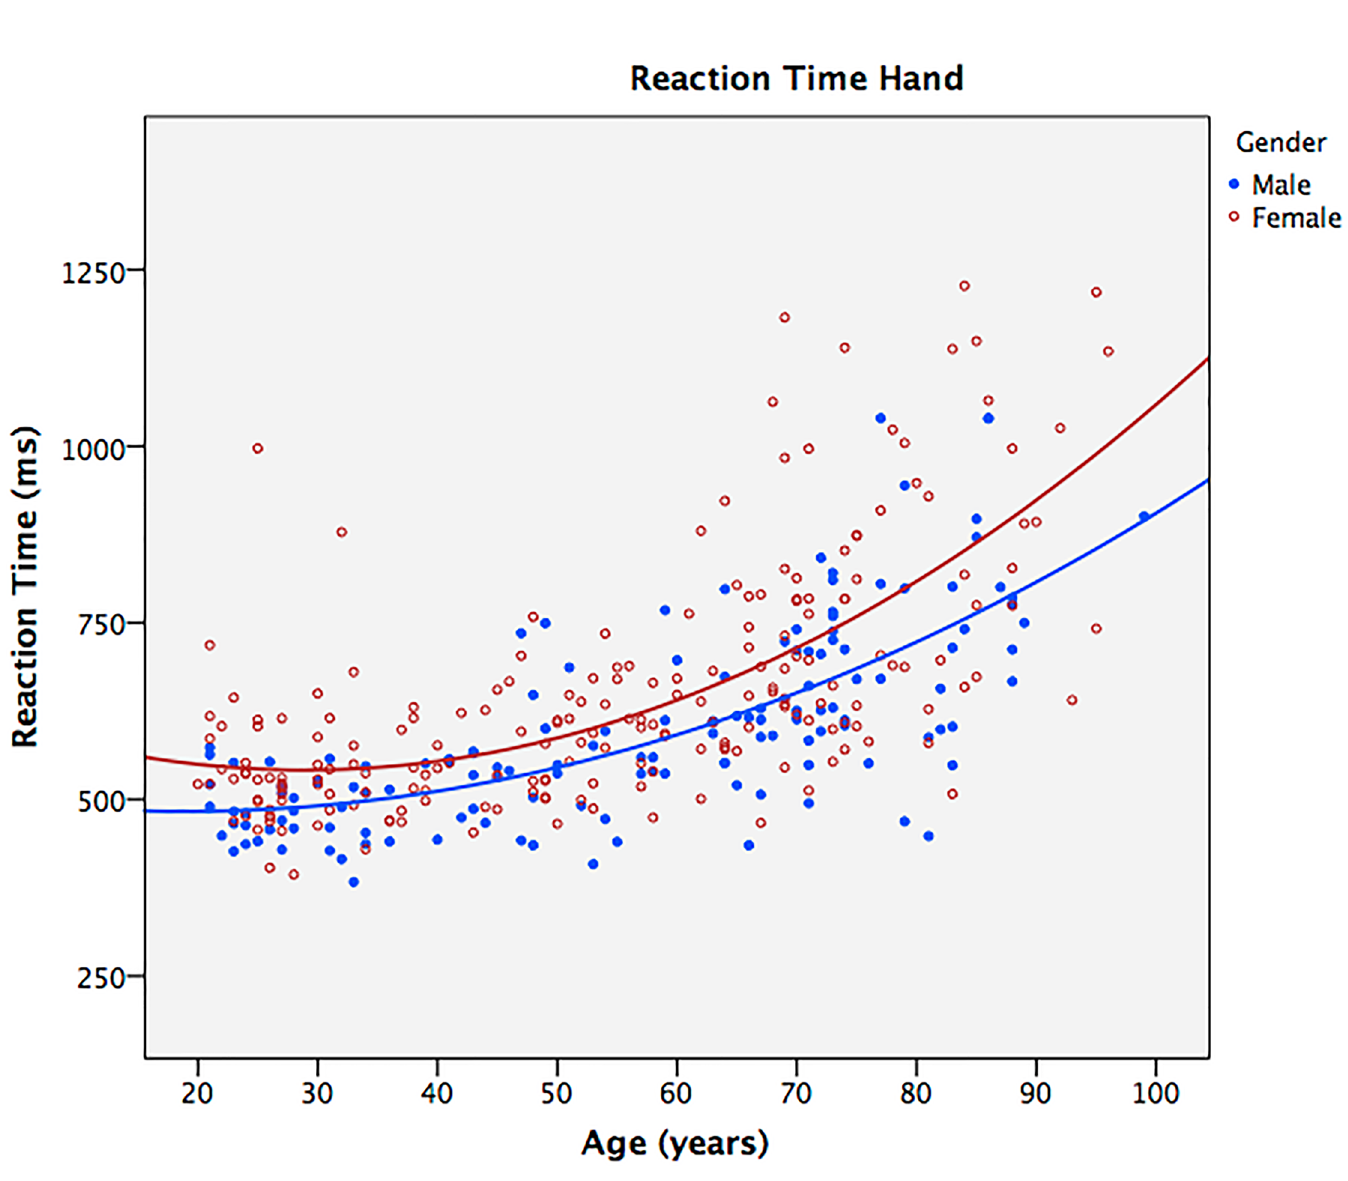
Fig 1. Reaction time hands: data points and quadratic